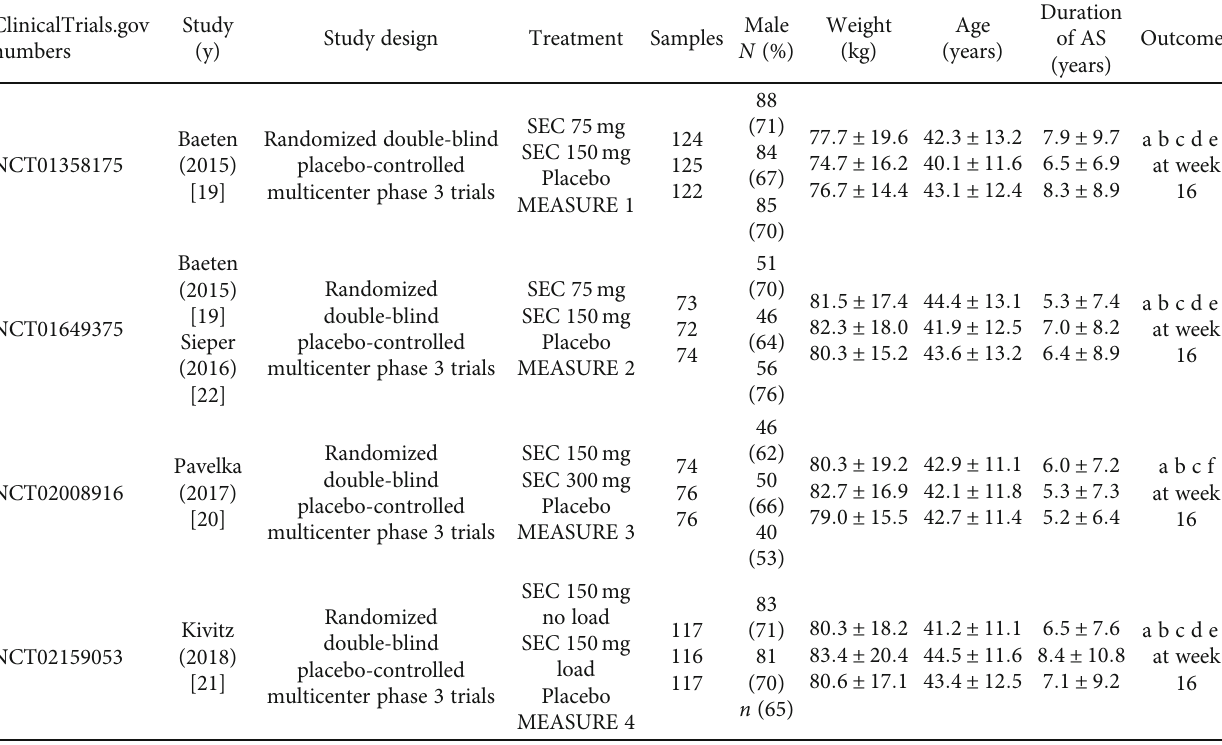
Table 1: Basic characteristics of all eligible studies.